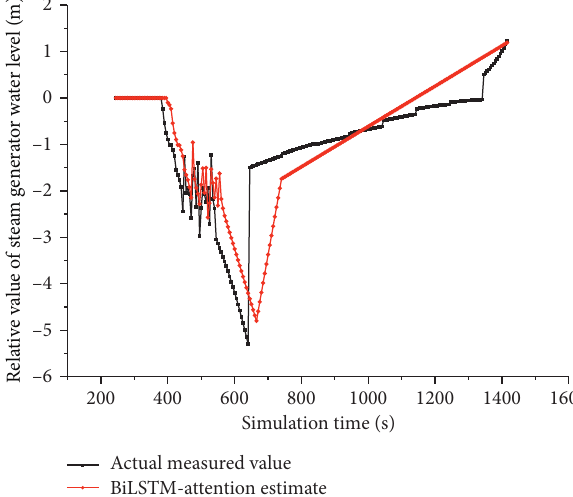
Figure 20: The comparison of the actual and predicted data of the steam generator water